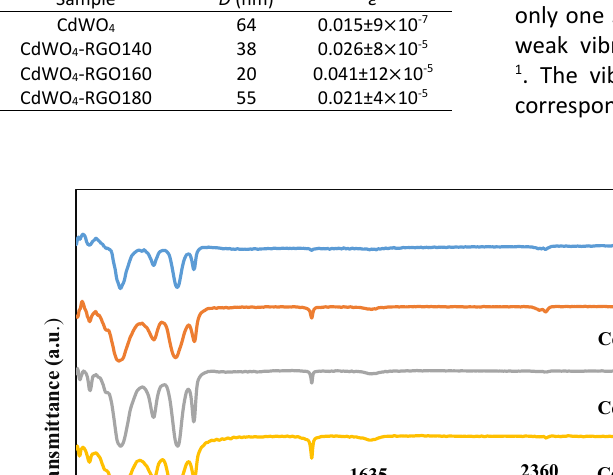
and CdWO -RGO140, 160 and 180 4 4